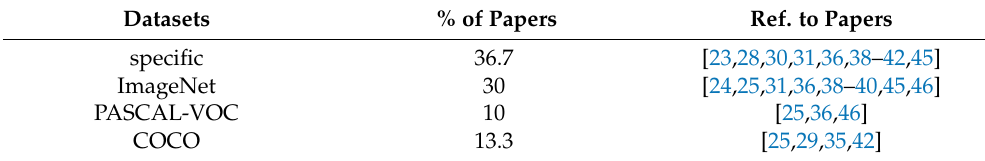
Table 9. The most frequent image